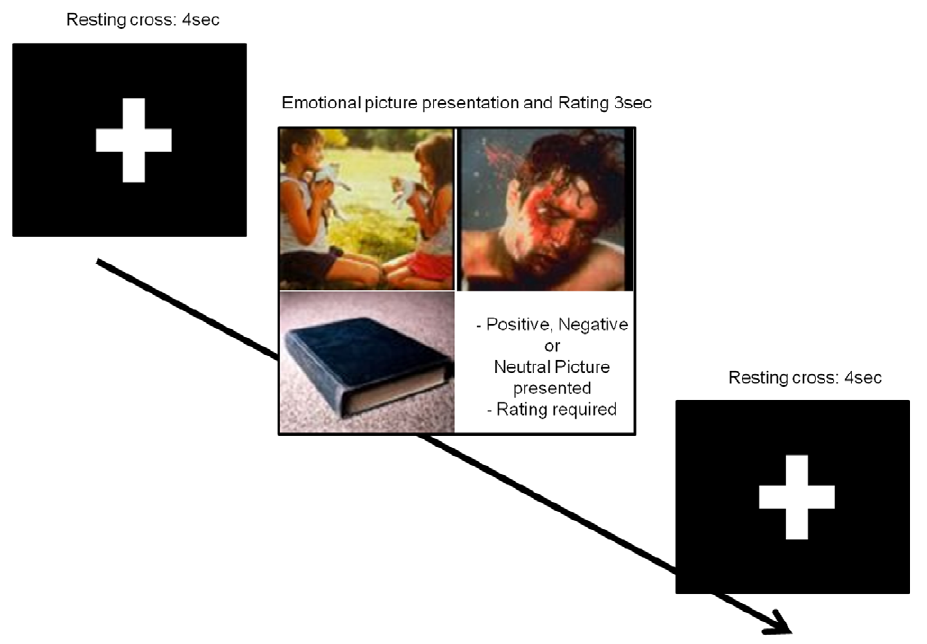
Figure 2. Stimulus presentation protocol and examples of pictures used in the study. Before the presentation of each picture a white cross was shown on the screen for 4 seconds, followed by a positive, negative or neutral picture for 3 seconds, requiring emotional rating by the subject. Then another cross was presented for 4 seconds. Note that although the example contains pictures of the three emotional valences (positive, neutral, negative), during the experiment only one picture corresponding to a single emotional valence was presented at each time.